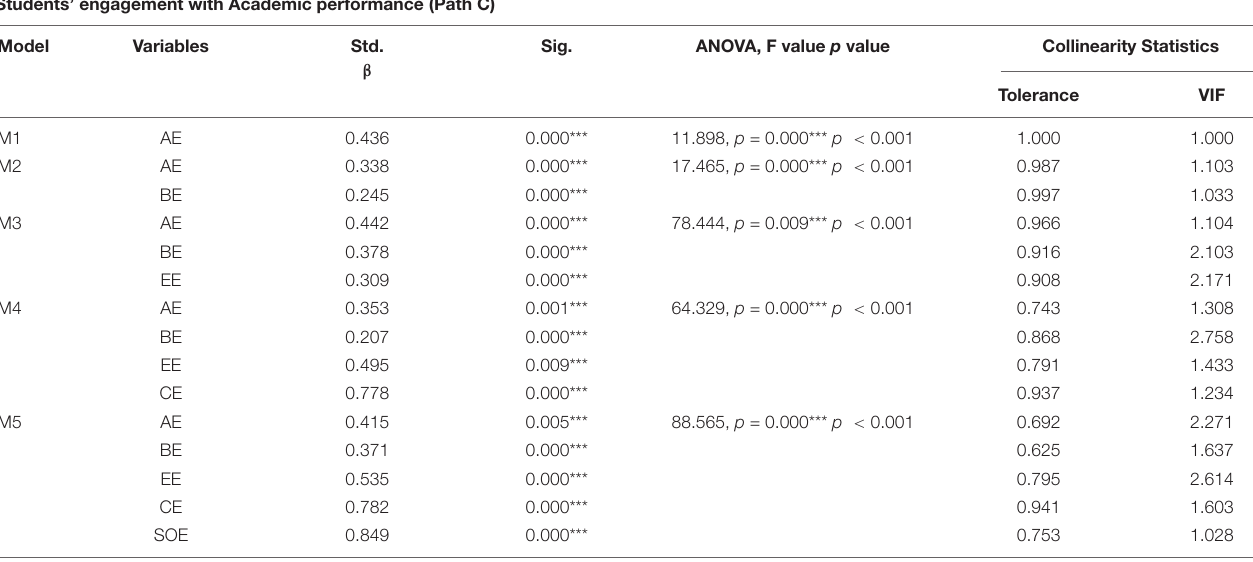
TABLE 8 | Multivariate linear hierarchical regression modeling (HLRM) about students’ overall engagement (AE + BE + EE + CE) with their academic performance in high schools ( N = 2,758). Students’ engagement with Academic performance (Path C)